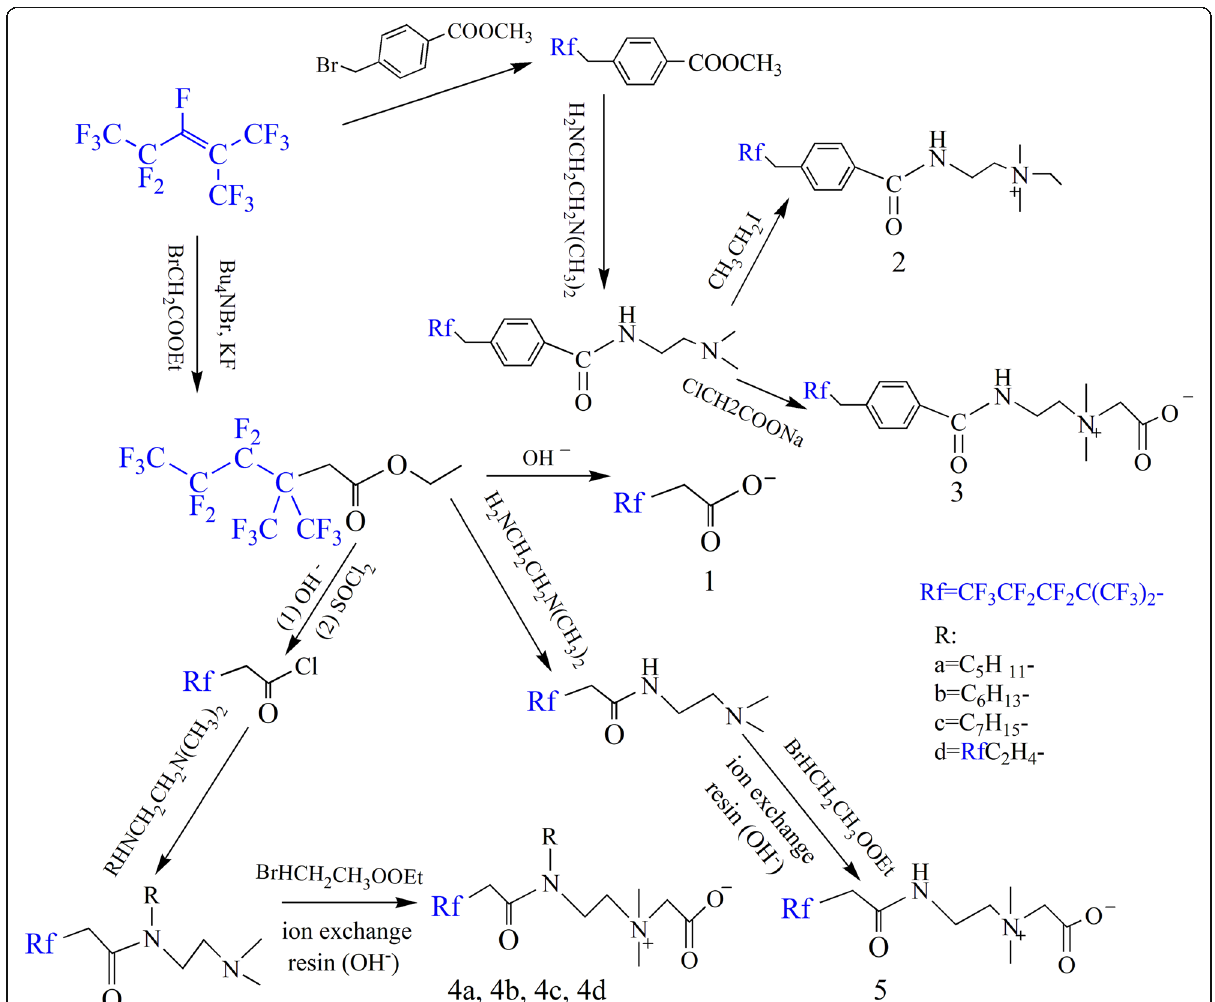
while the CMCs of sample 4d with two branched CF CF CF C(CF ) - group and sample 3 containing a 3 2 2 3 2 rigid benzene ring were 1.74× 10 − 6 and 1.04× 10 − 4 mol/L, respectively. Once again, the results proved that the intro- duction of an appropriate hydrophobic structure into the surfactant is beneficial to the formation of micelles and the decrease of CMC. Wei et al. [89] synthesized a branched fluorinated sur- factant (BFIS, as seen in Fig. 4a), which derived from hexafluoropropene trimer and 4-hydroxybenzyl alcohol, and compared its surface activity with a straight chain surfactant (SFIS, as seen in Fig. 4b). Owing to the exist- ence of rigid benzene ring and imidazole ring spacers, CMCs of BFIS and SFIS were lower but not distinctly different, with 0.122 and 0.181 mmol/L, respectively. And the surface tension could be effectively reduced to 18.66 mN/m for BFIS and 18.48 mN/m for SFIS,